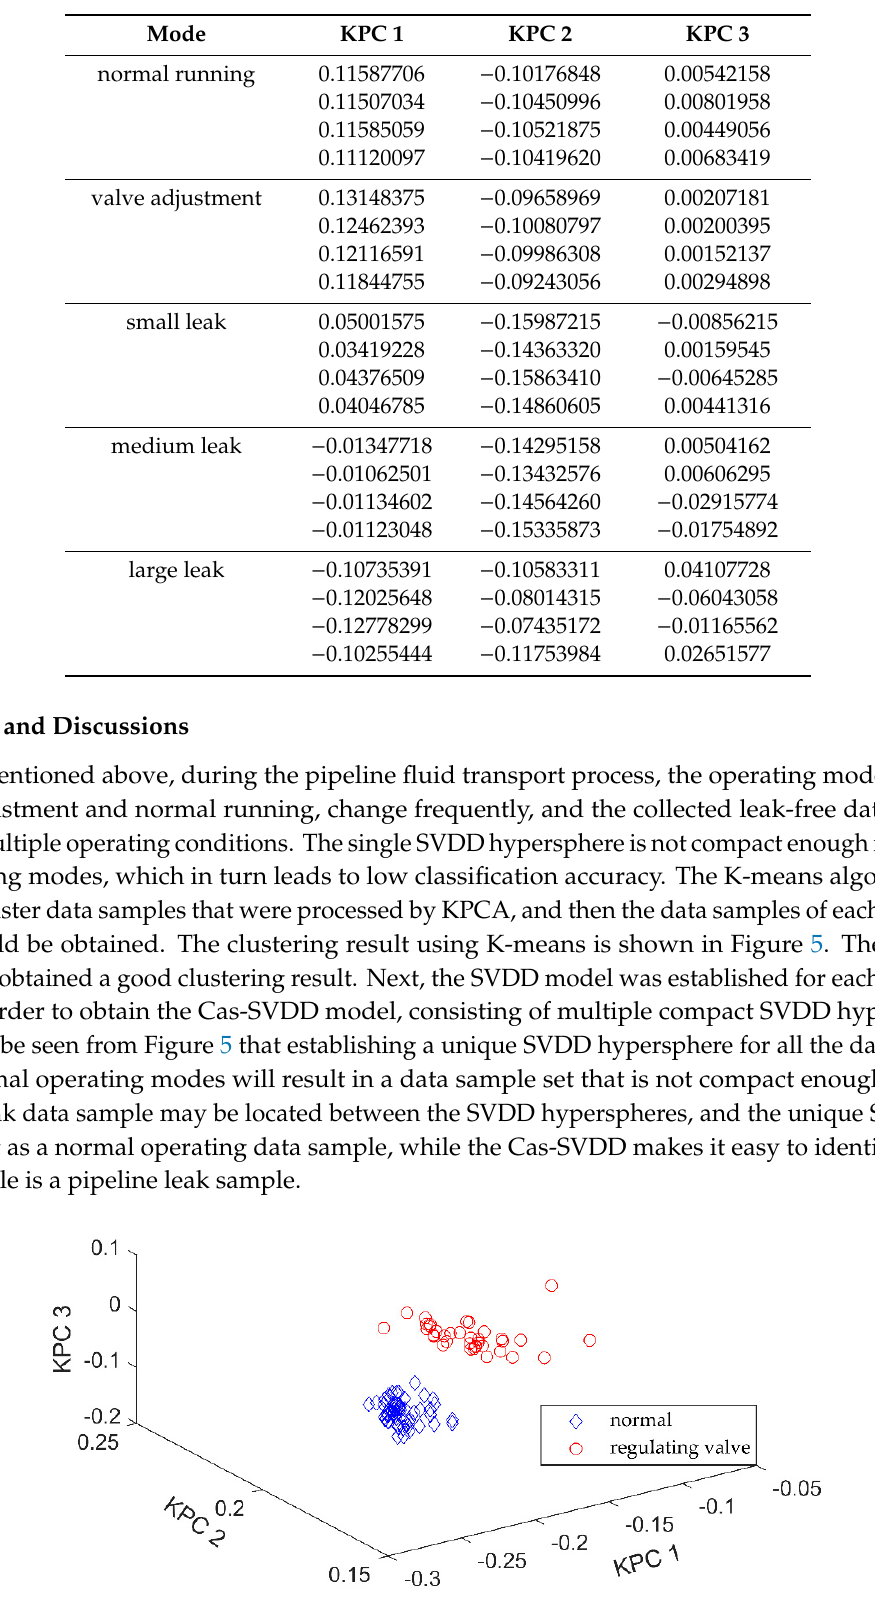
Table 3. Kernel principal components (KPC) data samples in di ff erent operating modes and leak scenarios.